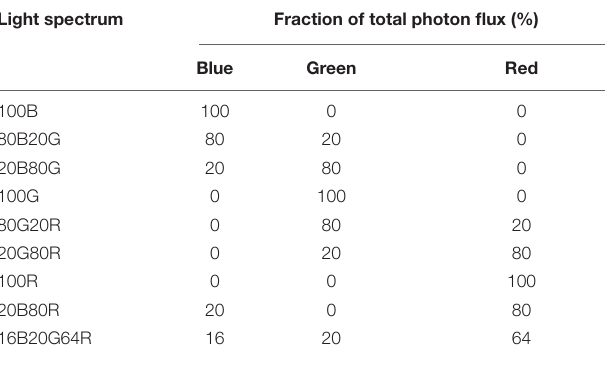
TABLE 1 | List of light spectrum abbreviations and their spectral